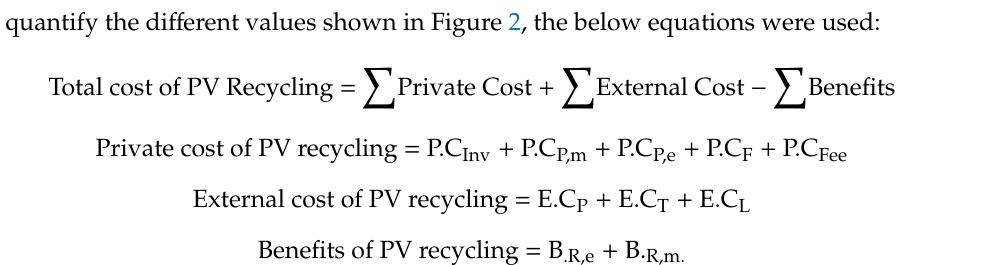
Figure 2. Our framework in analyzing the cost of FRELP recycling method.